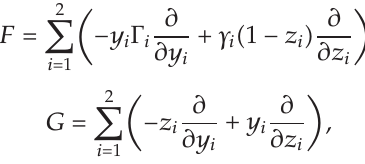
Figure 2: Plot of the optimal trajectories (cid:3) left (cid:4) and of the inversion recovery sequence (cid:3) right (cid:4) in the plane (cid:3) y,z (cid:4) . Experimental parameters are taken to be T experimentally measured trajectories are represented by filled squares and open diamonds. In the upper panel, the small insert represents a zoom of the optimal trajectory near the origin. The dotted line is the switching curve originating from the horizontal singular line. The solid curve is the optimal trajectory near the origin. The lower panel displays the corresponding control laws. τ is the reduced time defined by τ (cid:5) (cid:3) ω max / (cid:3) 2 π (cid:4)(cid:4) t